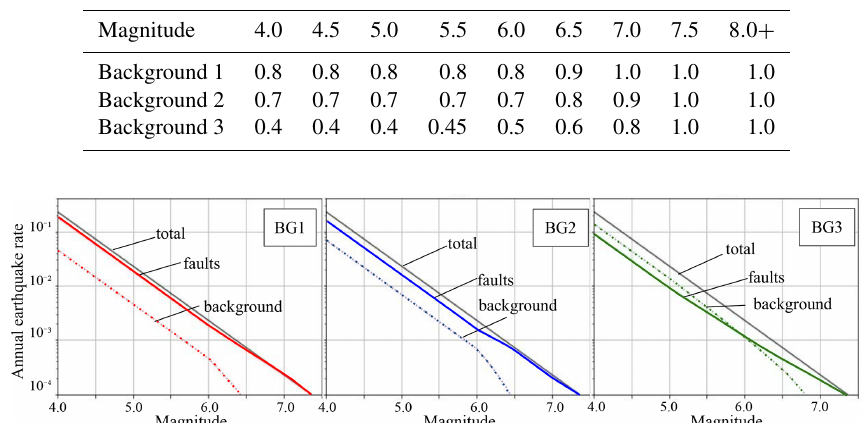
Figure 4. Distribution of earthquakes between the background seismicity and the faults for each background hypothesis. In black is the earthquake rate for the entire fault system (faults + background), the solid colour line is the faults only, and the dashed line is the background